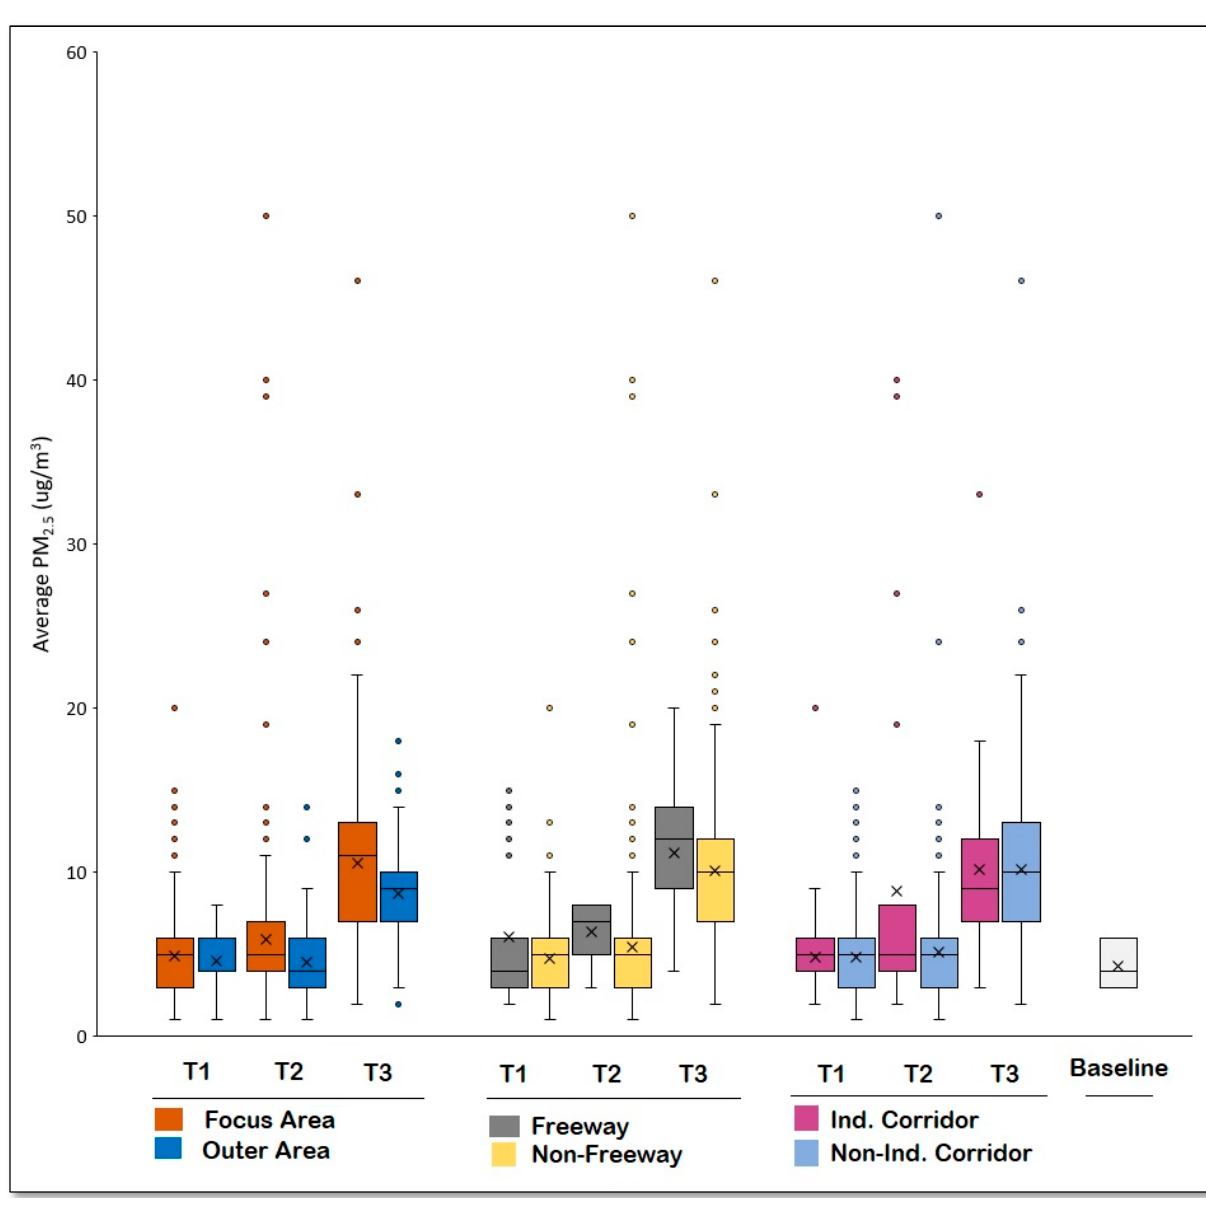
Figure 6. Boxplots of PM 2.5 concentrations averaged across each time period (T1 = morning, T2 = midday, and T3 = evening) and relevant urban features for measurements collected on the February sampling day. The symbol “X” indicates average concentrations.